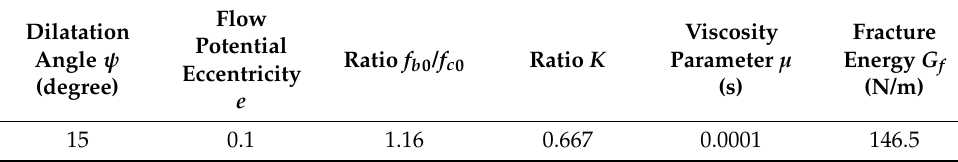
Table 6. CDP model parameters used in FEM